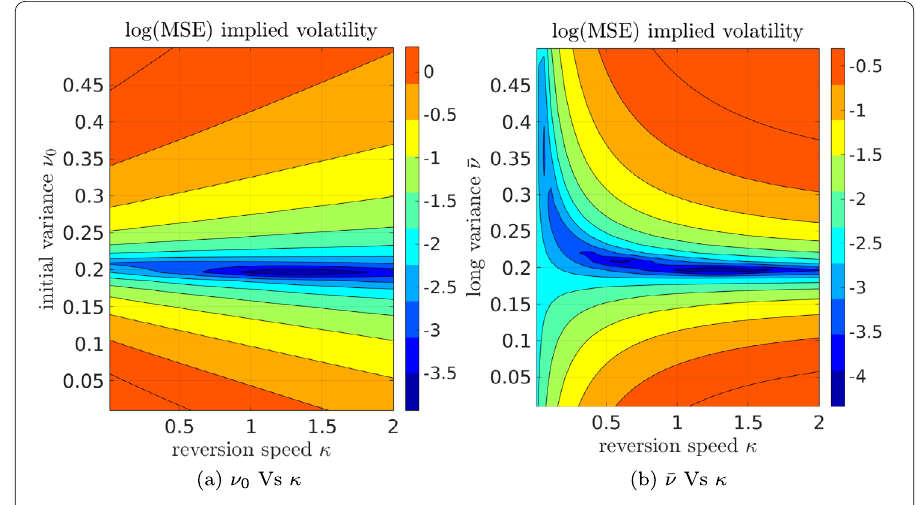
Figure 4 Landscape of the objective function for the implied volatility. The true values are κ ∗ = 1.0 and ν ∗ κ ∗ = 1.0 and ¯ ν ∗ = 0.2 in the right plot. There are 35 market samples. The objective 0 = 0.2 in the left plot, and function is MSE. The contour plot is rendered by a log-transformation